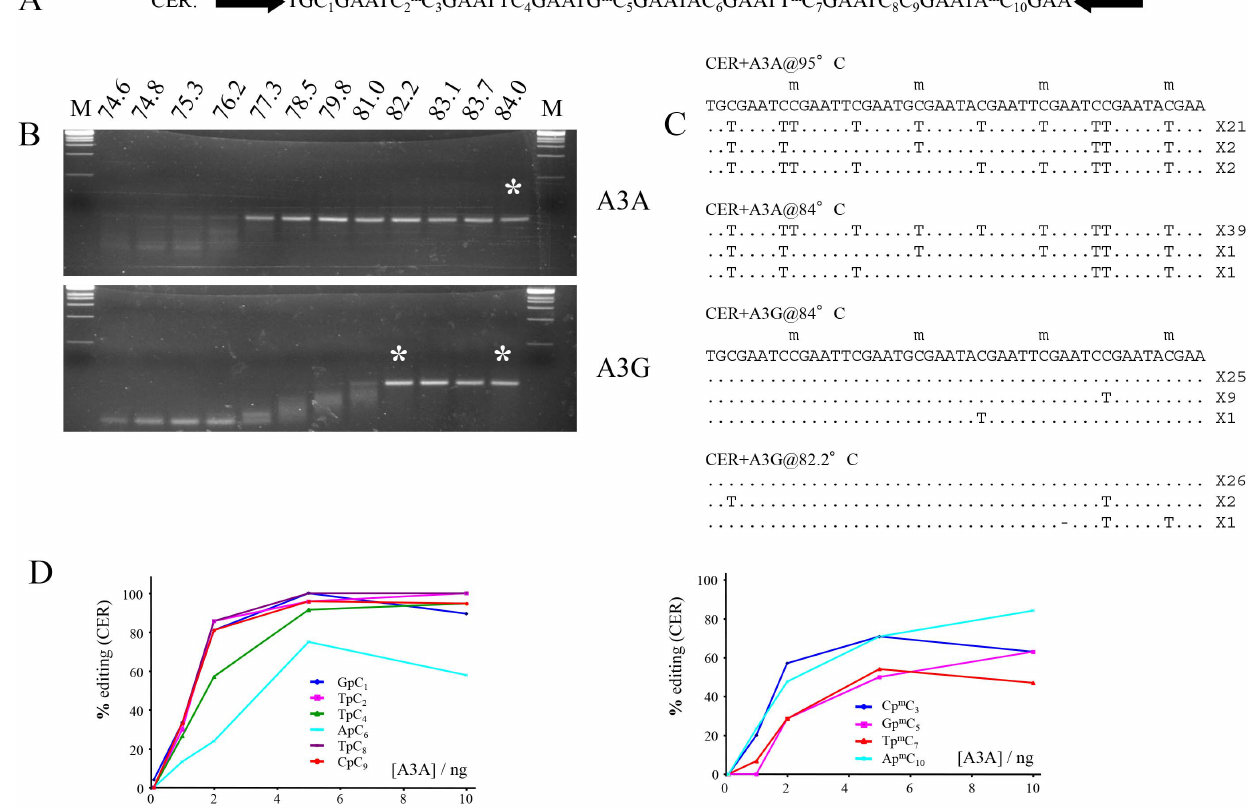
Figure 2. Similar A3A editing of 5MeC and C invitro. A) The CER target sequence is nested between two PCR primer targets (black arrows). Every 5MeC site has matched non-methylated equivalent to allow comparisons. B) 3DPCR recovery of A3A edited CER DNA. A3A-myc-His was purified from HEK293T cells as described [18]. The asterisks denote the PCR products cloned and sequenced. C) A selection of deaminated CER sequences with the number of mutant sequences shown to the right. D) Site specific cytidine and 5-methylcytidine deamination frequencies as a function of A3A concentration.